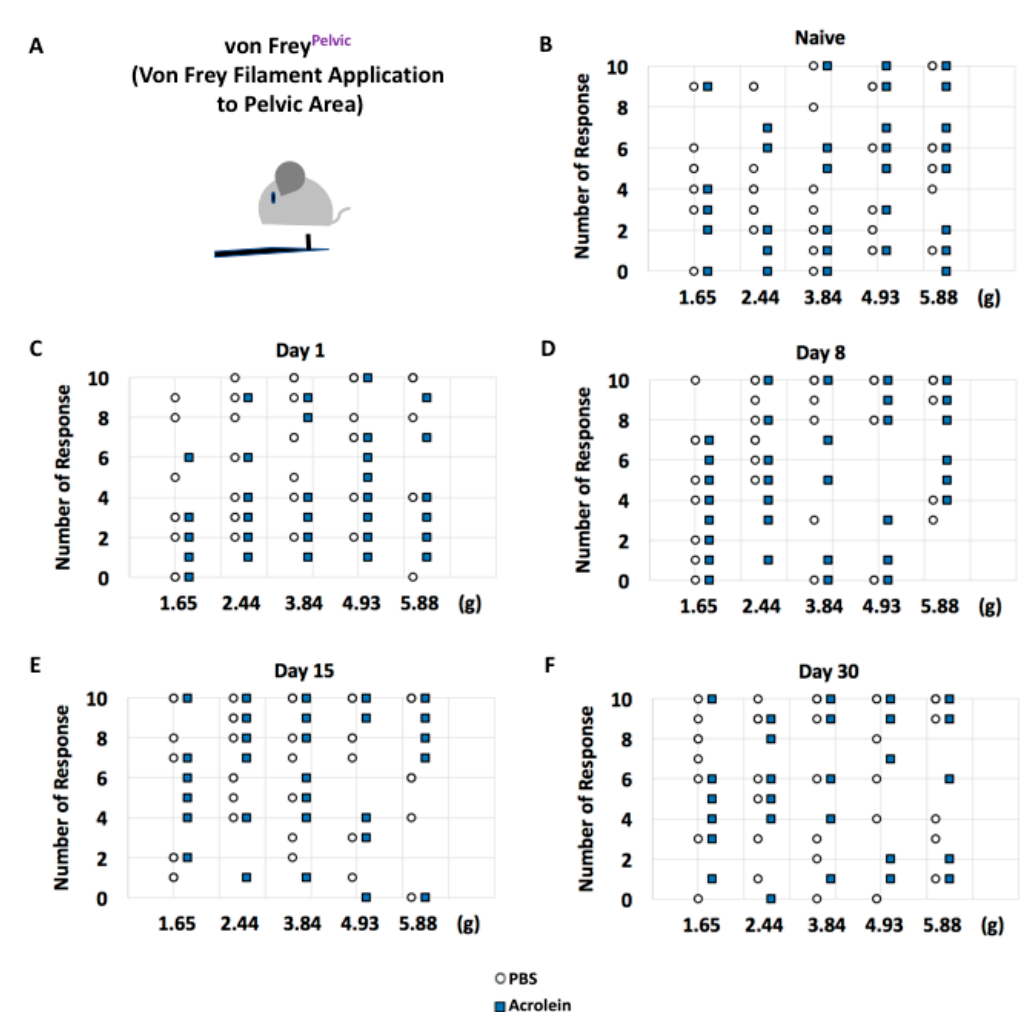
Figure 4. Assessment of abdominal withdrawal response to tactile stimulation in PBS vs. acrolein mice on the time points of naïve, days 1, 8, 15 and 30 pi as determined by von Frey application to the pelvic area. ( A ) Description of von Frey application to the pelvic area. The number of responses in response to an application of von Frey filament 1.65, 2.44, 3.84, 4.92 and 5.88 at naïve, days ( B ), 1 ( C ), 8 ( D ), 15 ( E ) and 30 ( F )